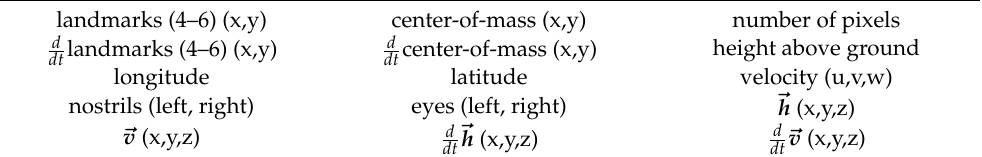
Table 1. List of known 15 noise sources and their individual components that were used in the de-noising